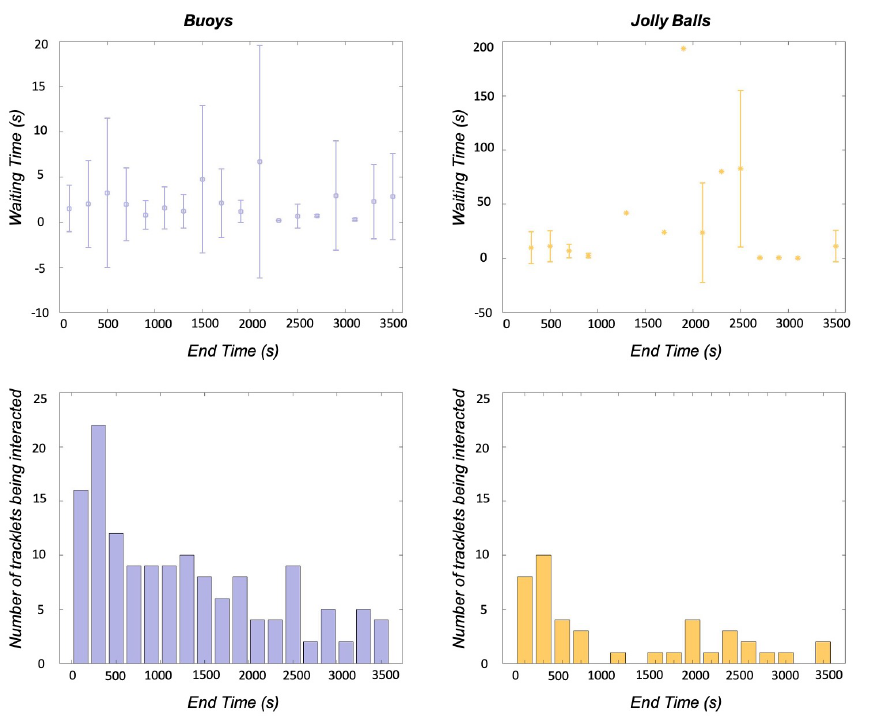
Figure 6. Average waiting time and standard deviation ( top ) and number of enrichment interactions ( bottom ) are shown for each 200-second-wide bins for two types of enrichment (Buoys and Jolly Balls). The waiting time for buoys is lower than that for Jolly Balls in general (note that the y-axes for waiting time are on different scales). The numbers of interactions for both enrichment show decreasing trends as the trials